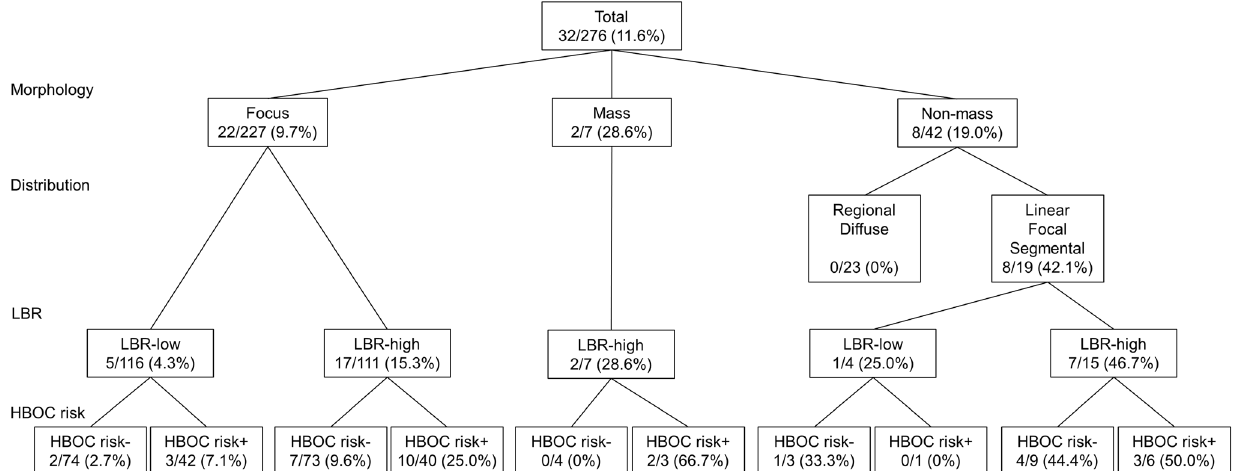
Figure 1. Probabilities of malignant lesions according to uptake patterns, LBR, and hereditary risk in incidental uptake on dedicated breast PET. HBOC risk is defined as having either contralateral breast cancer or family history of breast and ovarian cancers. PET positron emission tomography, HBOC hereditary breast and ovarian cancer, LBR lesion-to-background